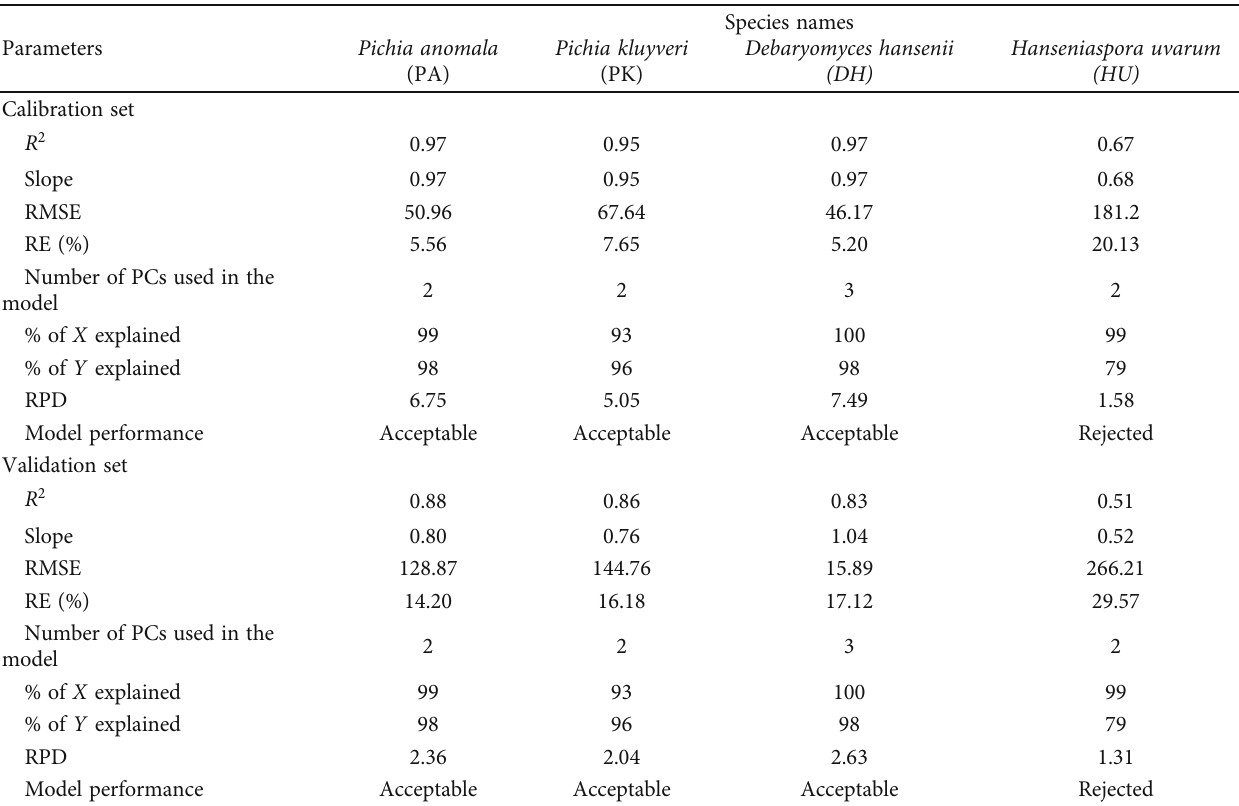
Table 2: Results of partial least squares (PLS-1) models for four strains using electronic nose (as X matrix) and the concentration of each strain (as Y matrix) using three sensors (MQ-2, MQ-135, and MQ-138). The di ff erent parameters are shown in calibration and validation methods. Full cross-validation was